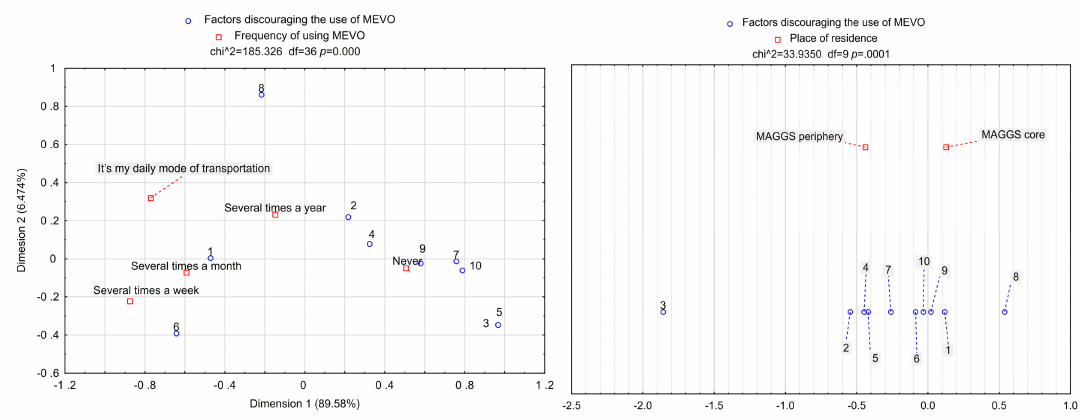
Figure 4. Correspondence analysis: Main factors discouraging the use of Mevo versus the frequency of